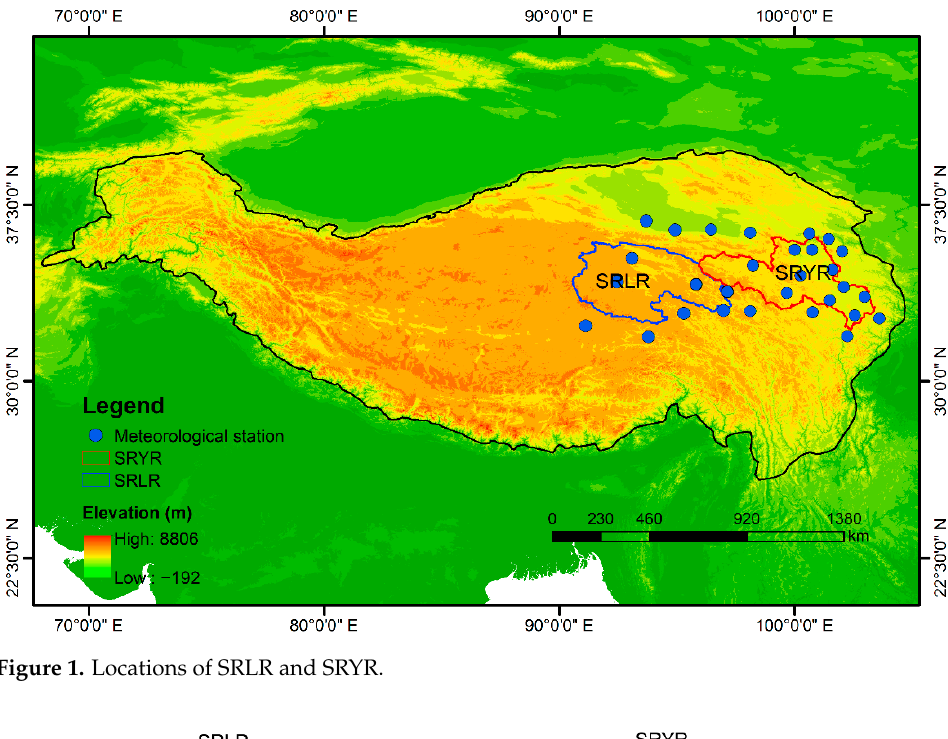
Figure 1. Locations of SRLR and SRYR.